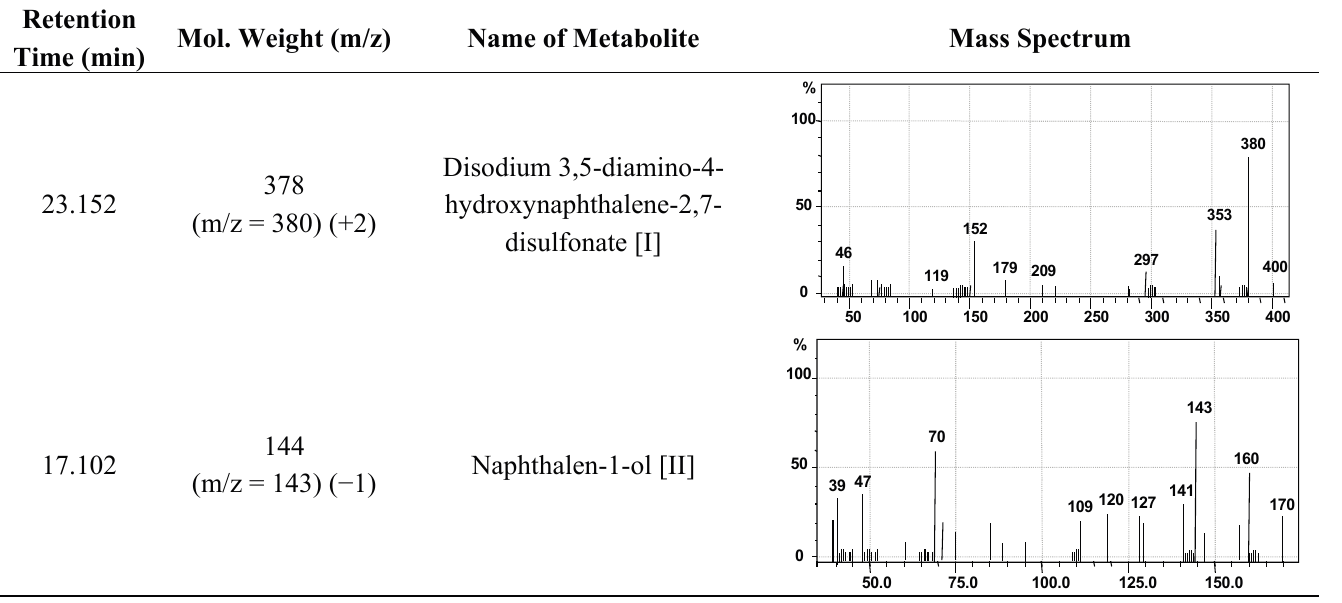
Table 4. GC-Mass spectra of products obtained after degradation of Trypan Blue by microbial